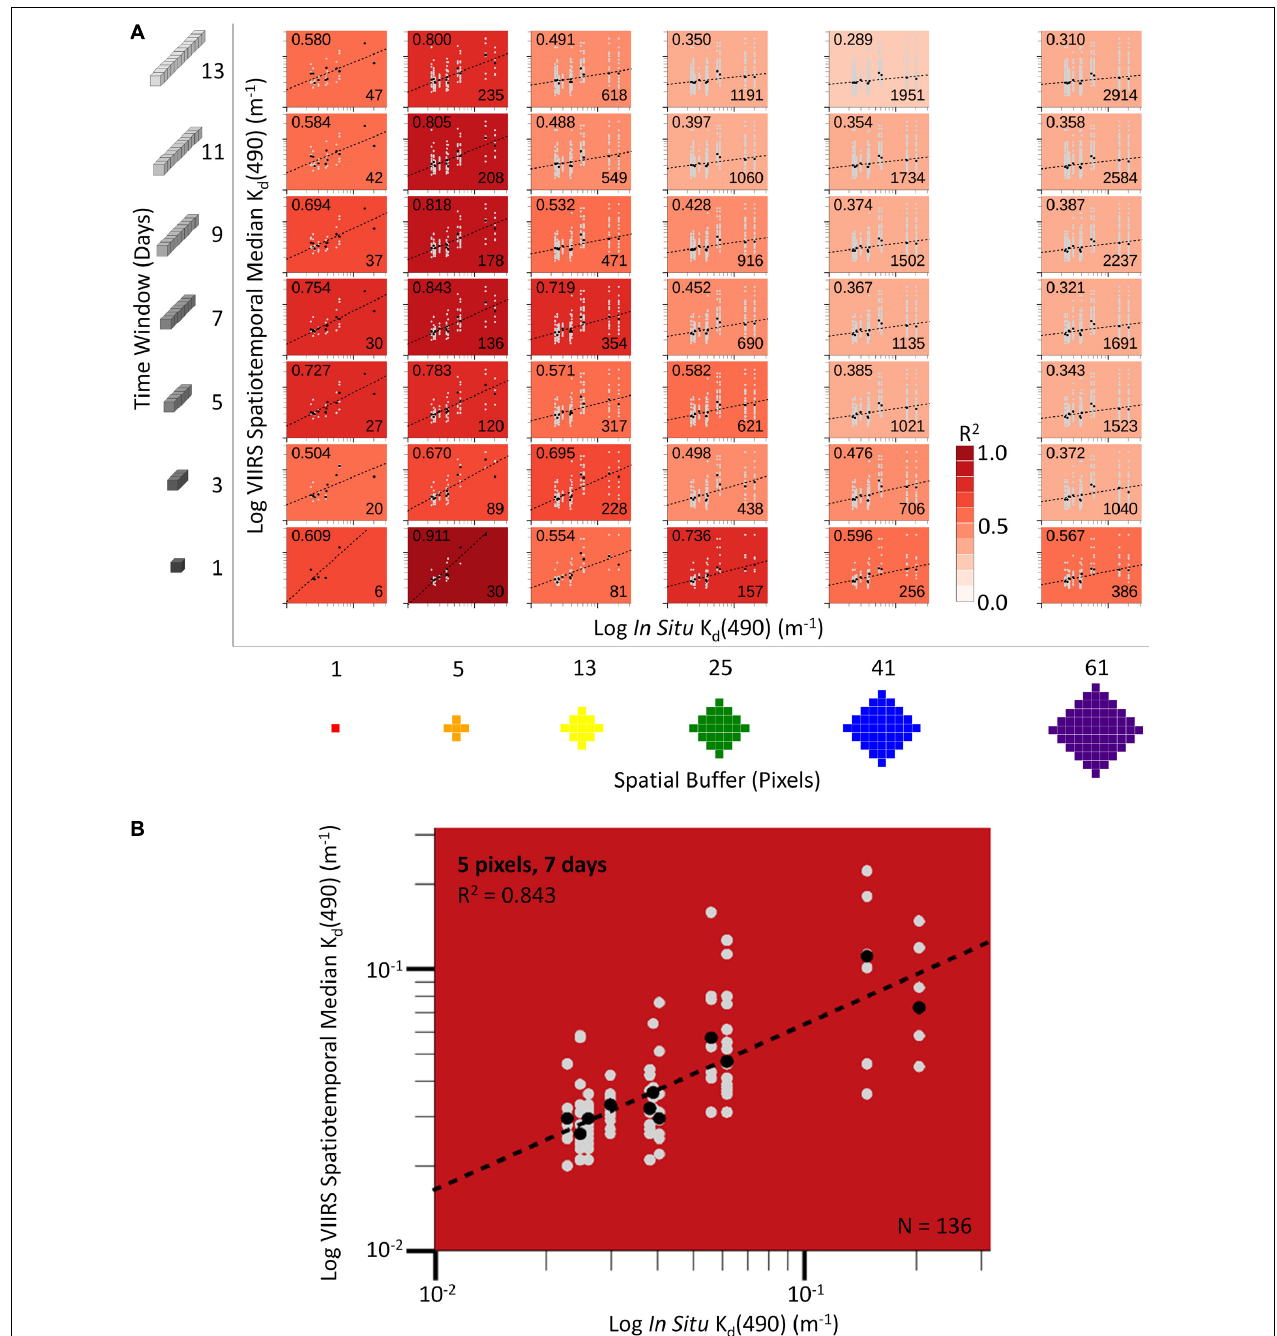
FIGURE 5 | (A) Correlation matrix of in situ and VIIRS measures of log-transformed K d (490) over a three-days in situ measurement period at 11 West Maui locations ( Figure 2 ) for a range of spatial buffers and time windows applied to the satellite data. The outer horizontal axis indicates the spatial buffer and the outer vertical axis represents the time window, with icons on each representing the space (or time) domain. Together, the time window and spatial buffer make the spatiotemporal cube of satellite data from which values are compiled (gray circles) and the median of those is calculated (black circles). Shading of each plot represents the R 2 value of individual regression lines between the median satellite observation and the in situ observations. For each scatterplot, the horizontal axis values are the in situ observations from the sites in Figure 2 , all of which were taken during November 26–28, 2018, and the vertical axis values are all satellite observations associated with that in situ measurement within the time window and space buffer indicated. The number in the upper left corner is the R 2 value for that plot; the number in the bottom right corner is the total number of satellite observations (gray circles) displayed in the plot. (B) Enlarged scatterplot for recommended spatiotemporal aggregation (5-pixels, 7-days). Axis tick values in (B) are the same as all scatterplots in (A) and major tick marks are bold for all scatterplots.